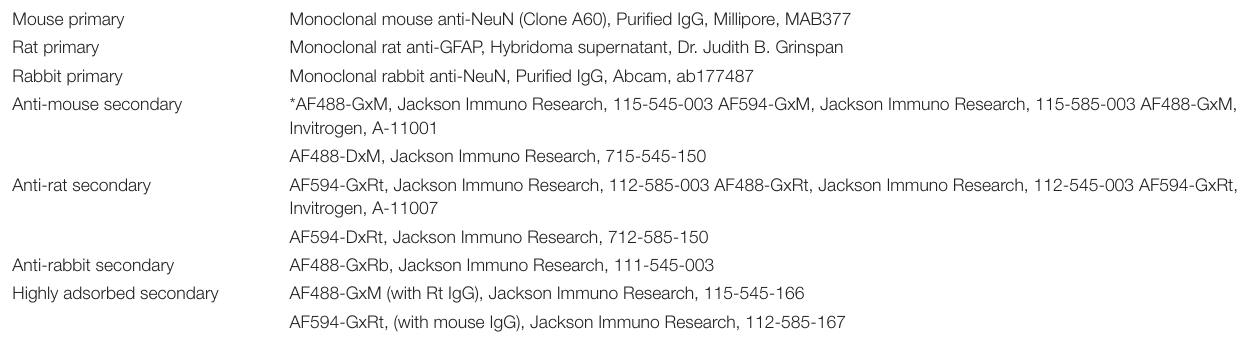
TABLE 1 | List of antibodies used in the present